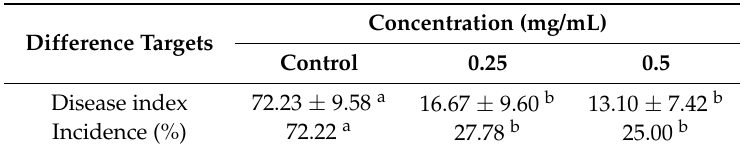
Table 4. Effect of the petroleum ether extract from A . annua on disease index and incidence of P . notoginseng plants infected by pathogenic